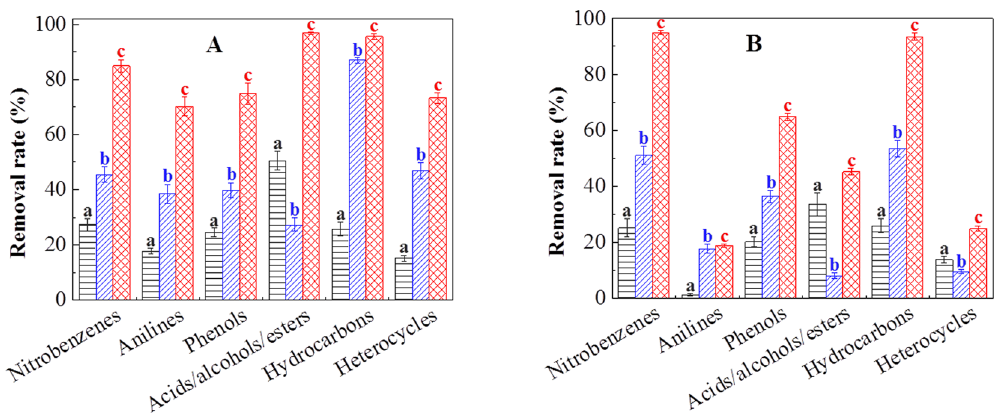
Figure 3. Removal rate of organic contaminants by (a) PAC coagulation, (b) the one-step process of organobentonite and (c) the one-step process of organobentonite with PAC for ( A ) DR 145 and ( B ) DR 167. Bentonite dose: 0.5 g L − 1 , CTMAB dose: 60% CEC, PAC dose: 0.5 g L − 1 . Error bars represent standard deviations ( n =